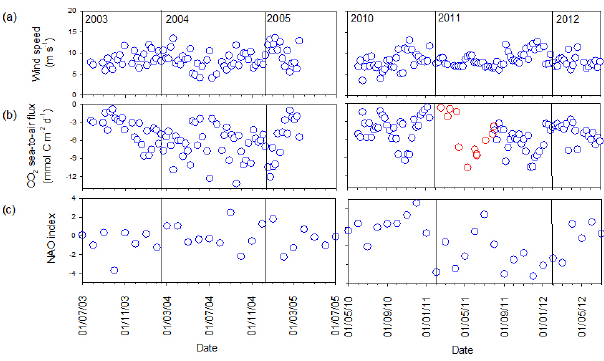
Figure 5. Data from 2003 to 2005 and 2010 to 2012 (blue circles) for (a) weekly satellite wind data in the region of the PAP-SO; (b) calculations of weekly sea-to-air CO 2 flux (negative: into the ocean) from in situ PAP-SO p (CO 2 ) data and satellite wind (see text for details) with additional flux calculations from SOO data (red circles); (c) the monthly NAO